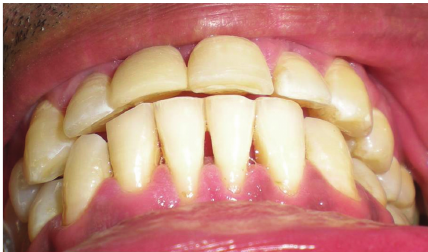
Figure 5: Incisal view of definitive